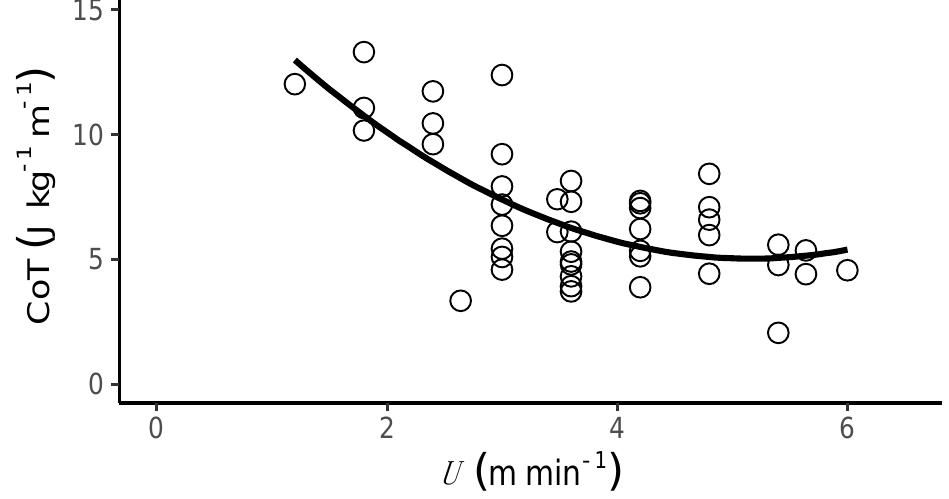
Figure 1. The metabolic cost of transport (CoT, J kg − 1 m − 1 ) of locomotion on a level treadmill over a range of speeds ( U , m min − 1 ) in the Mediterranean spur-thighed tortoise ( T. graeca ). The relationship between CoT and U is best described by a curvilinear fit (Table 1), which suggests that Mediterranean spur-thighed tortoises have an optimal speed (between 4–6 m min − 1 ) at which the CoT is min- imised.